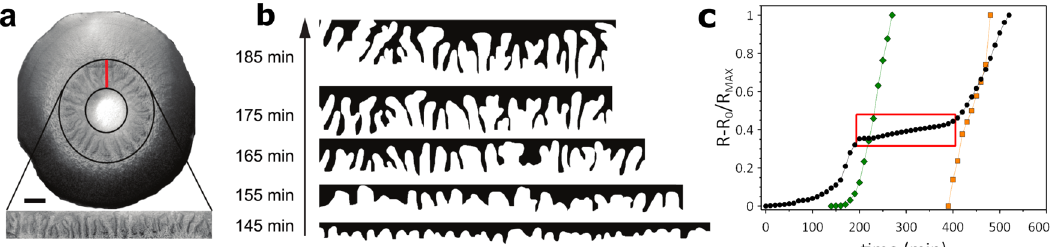
Fig. 3 Large scale dynamics in polysaccharide-minus bio fi lms. a An example of a microscopy image of an entire epsA-O bio fi lm (scale bar is 500 μ m). Annular black region de fi nes the area where we observe fi nger-like instabilities. This annular region is made linear for ease of visualization; a cut is made at the red line and the circular region is `unrolled' to form a linear region. b Binarized images of the fi ngers over time for the bio fi lm in ( a ). c The normalized displacement as a function of time for the outer edge of the colony (black circles), fl uid front (green diamonds) and motility arrest front (orange squares). A plateau in the edge expansion occurs coincidentally with the onset of fl uid propagation (which we de fi ne as the ` fl uidisation plateau'; red box). The growth recommences after motility becomes arrested. The green curve corresponds to the time when we observe the fi ngers develop in ( a ).